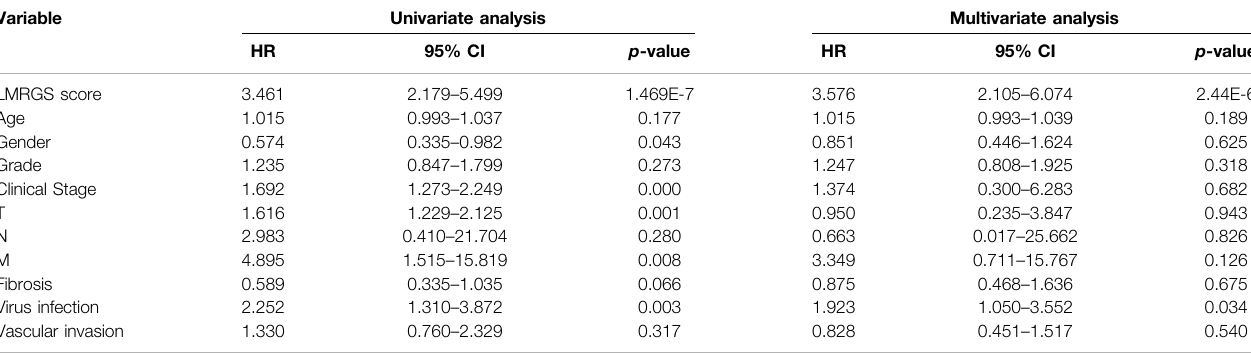
TABLE 2 | Univariate and multivariate Cox regression analyses of the LMRGS score in the TCGA. Variable